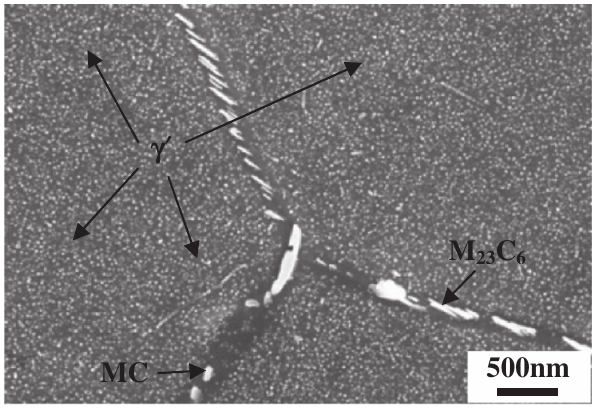
Figure 1: Microstructure of alloy A286 after heat